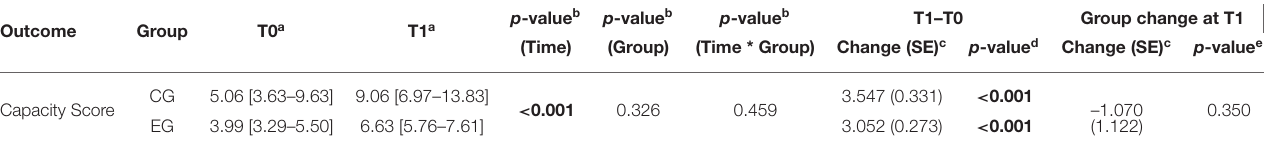
Control group ( N = 14)